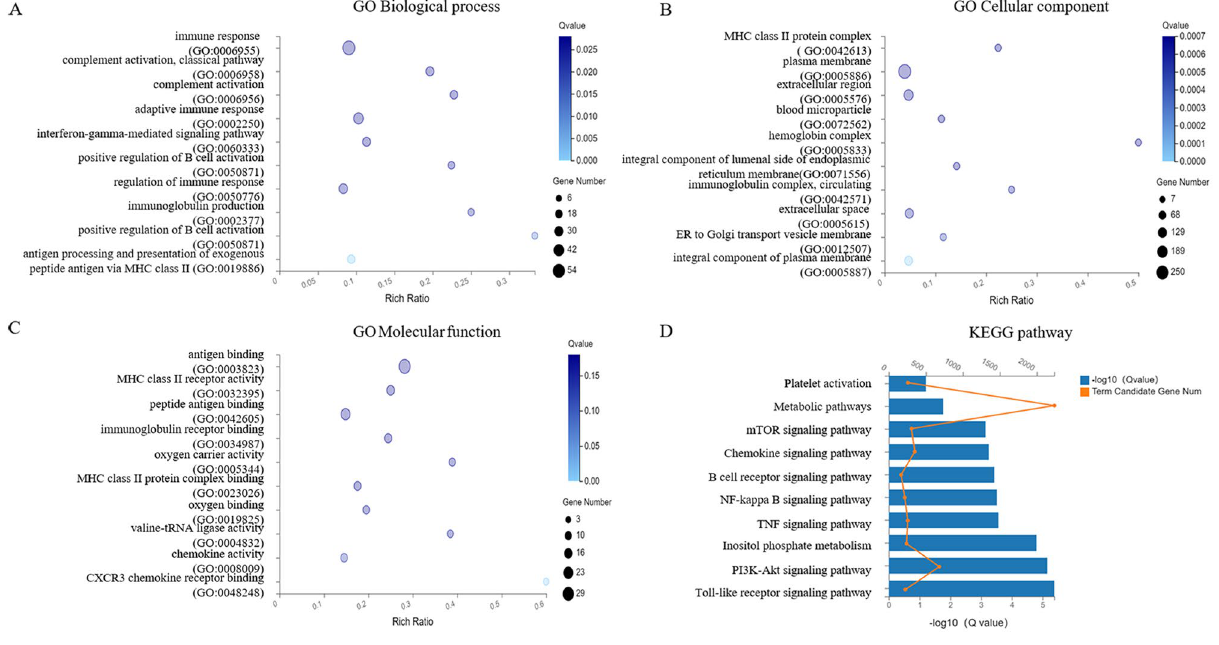
Figure 2. GO and KEGG Pathway enrichment analysis of differentially expressed long noncoding RNAs. ( A – C ) The y-axis represents the pathway entry, and the x-axis represents the rich ratio. The size of dot is directly proportional to the number of differentially expressed genes. The colors of each dots represent different Q values. ( A ) The biological process in which the target genes are significantly enriched; ( B ) Cell components in which the target genes are notably enriched; ( C ) molecular functions in which the target genes are markedly enriched. ( D ) KEGG pathways significantly associated with the target